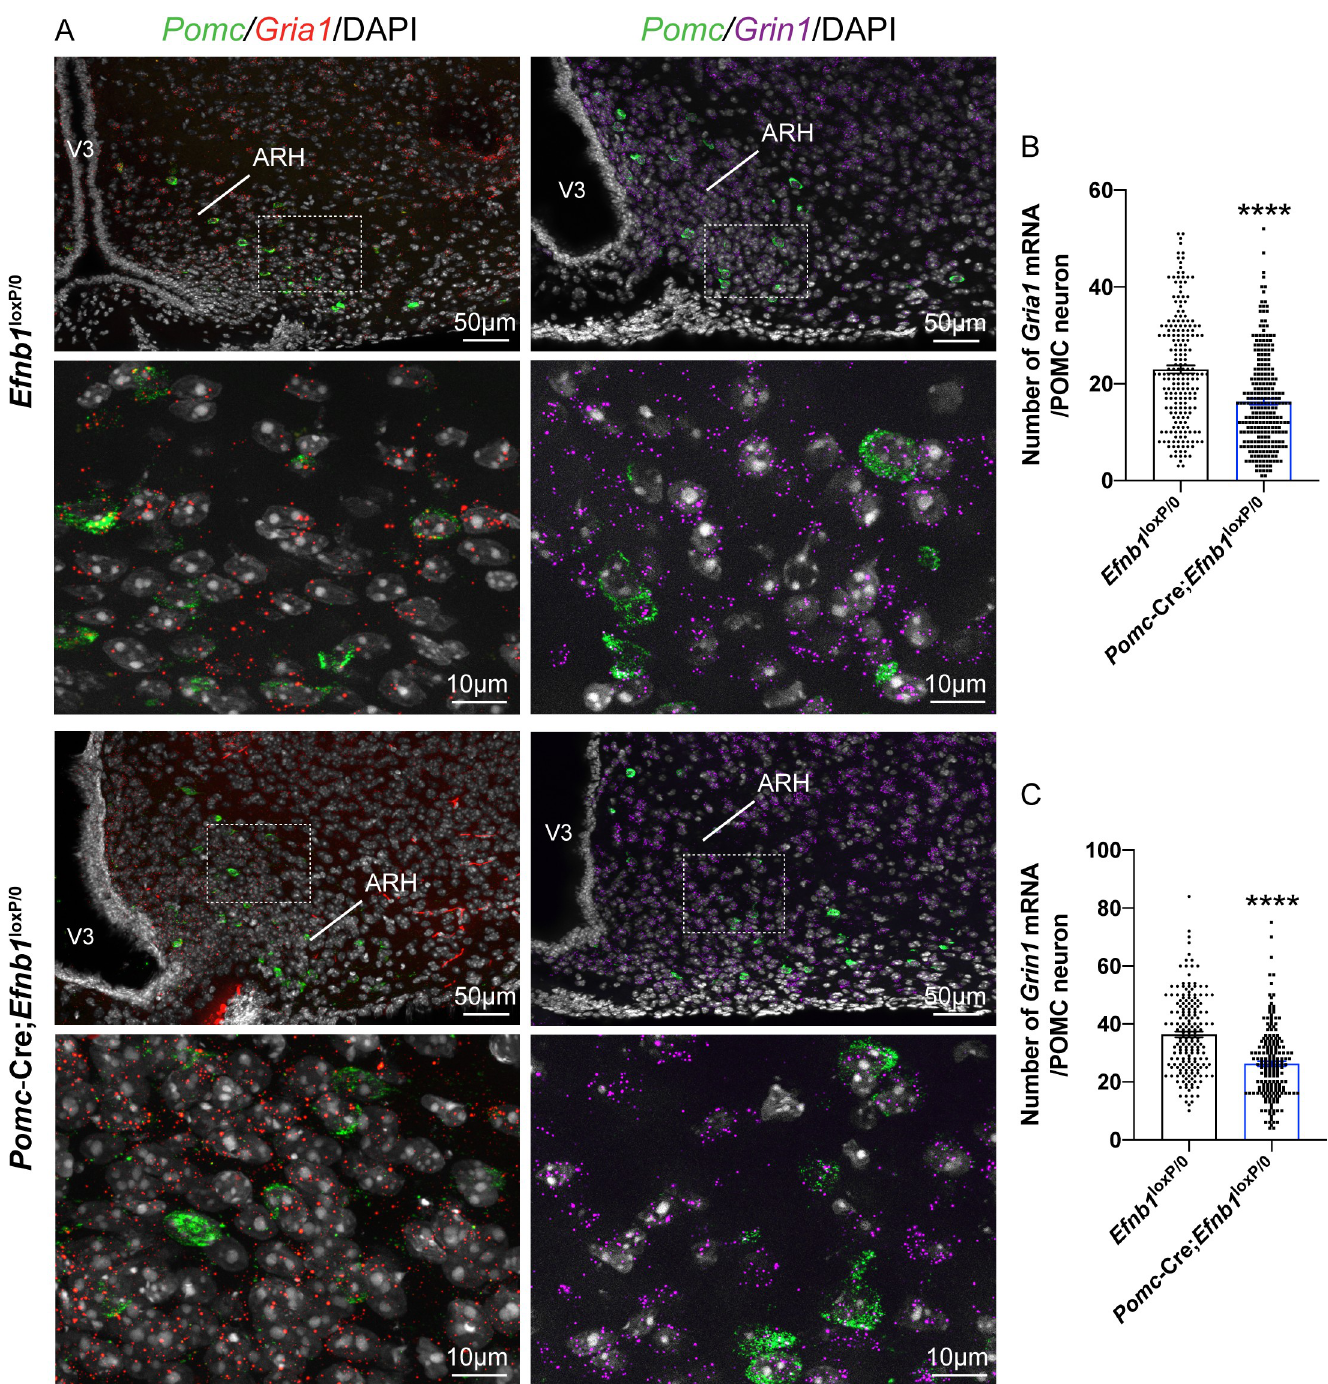
Fig 4. Gria1 and Grin1 mRNA expressions in POMC neurons is impaired by the lack of Efnb1 in POMC-expressing progenitors. (A) Microphotographs showing Gria1 (red) and Grin1 (purple) mRNA spots in Pomc -expressing neurons (green) neurons in the ARH of 19–20-week-old male mice. DAPI counterstaining is shown in white. Quantification of the number of Gria1 (B) and Grin1 (C) mRNA spots in POMC neurons ( n = 2–3 animals/group, n = 206–263 neurons/group). Data are shown ± SEM. Statistical significance was determined using 2-tailed Student t test (B, C). ���� P � 0.0001 versus Efnb1 loxP/loxP male mice (B, C). The underlying data are provided in S1 Data. ARH, arcuate nucleus of the hypothalamus; POMC, proopiomelanocortin; SEM, standard error of the mean; V3, third ventricle.